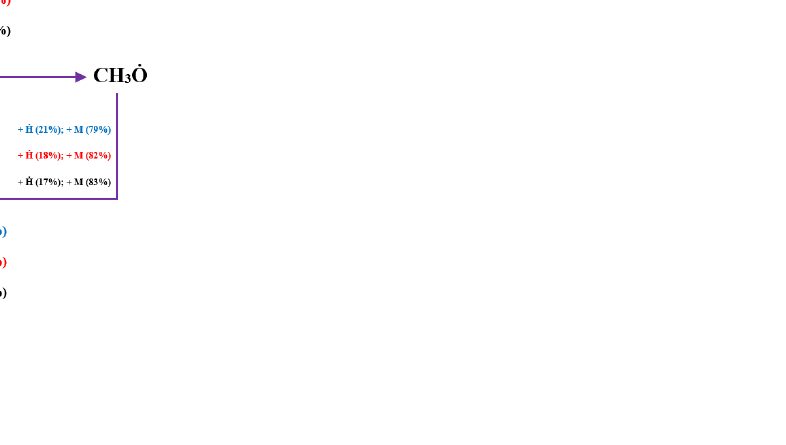
Figure 6. ( a ) Distribution of the H mass fraction on the inner wall for different diameters of the inserted wire; ( b ) distribution of the OH mass fraction on the inner wall for different diameters of